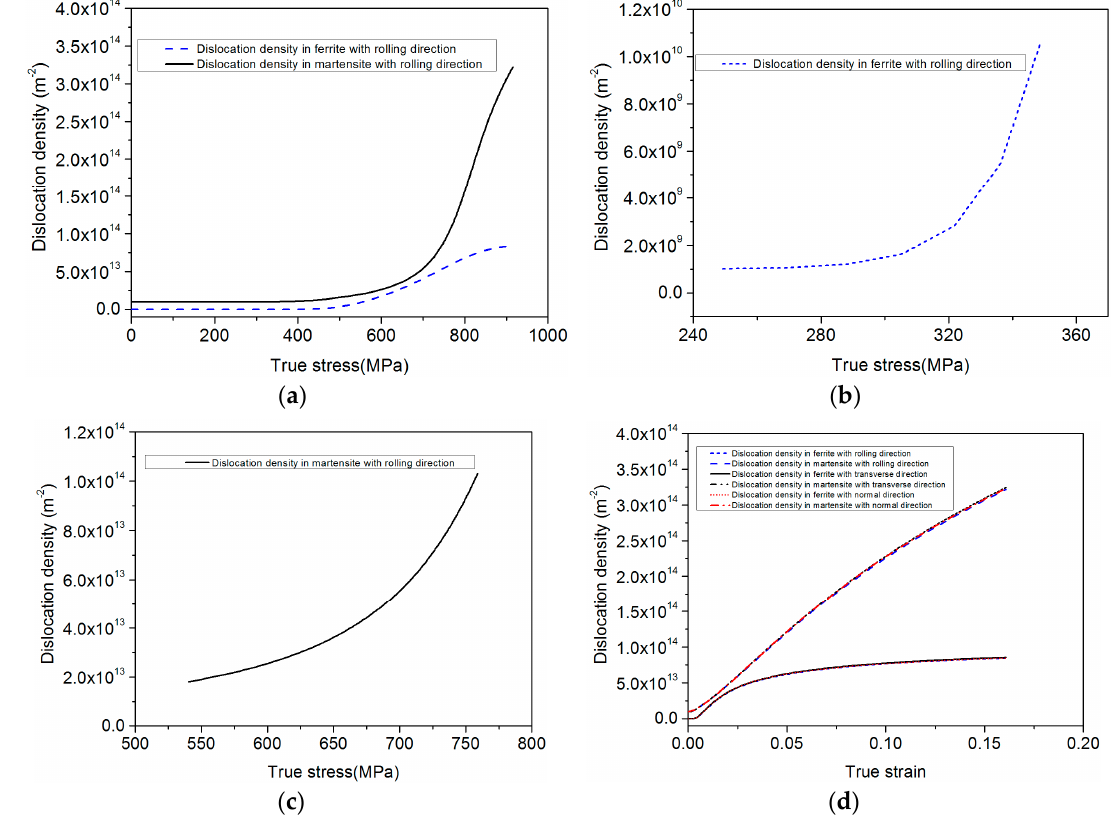
Figure 8. The dislocation density evolution. ( a ) The evolution curves of ferrite/martensite dislocation densities with true stress. ( b ) Partial curve of ferrite dislocation density evolution with true stress. ( c ) Partial curve of martensite dislocation density evolution with true stress. ( d ) The evolution curves of ferrite/martensite dislocation densities with true strain.